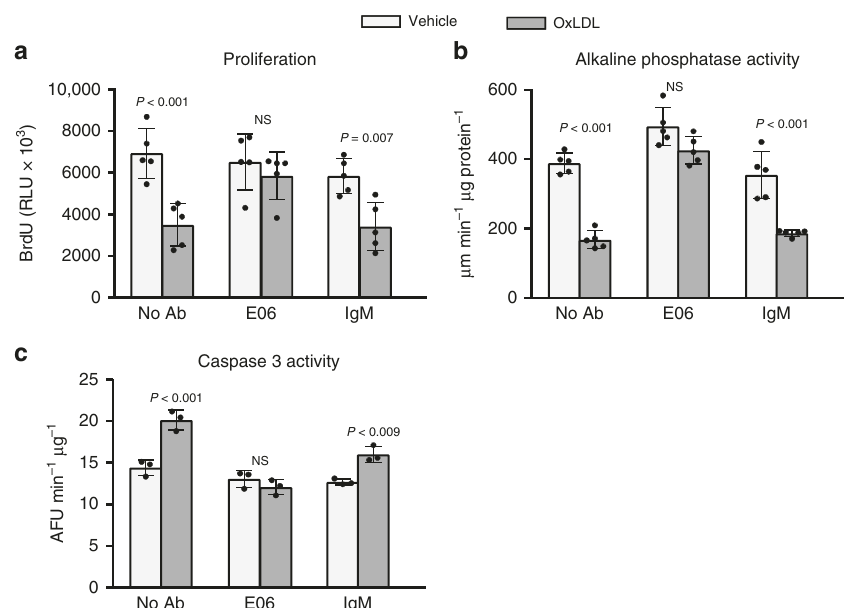
Fig. 1 E06 prevents the effects of OxLDL on osteoblast apoptosis, differentiation and proliferation. Osteoprogenitor cells from bone marrow were pre- treated for 1 h without (no Ab), or with E06 (2 µ g/ml), or with murine IgM ('IgM', 2 µ g/ml), in the absence ('veh') or presence of OxLDL (50 µ g/ml) for a 2 days prior to measurement of BrDU incorporation, or b 2 days prior to measurement of alkaline phosphatase activity, or c 12 h prior to measurement of Caspase 3 activity. All measures were performed in triplicate cultures. Essentially identical results were obtained in a separate experiment. Data were analyzed by ANOVA; the p values re fl ect comparison to the respective vehicle. Data shown represent the mean (±SD). AFU: Arbitrary fl uorescence units, RLU: Relative luminescence units, NS: not signi fi